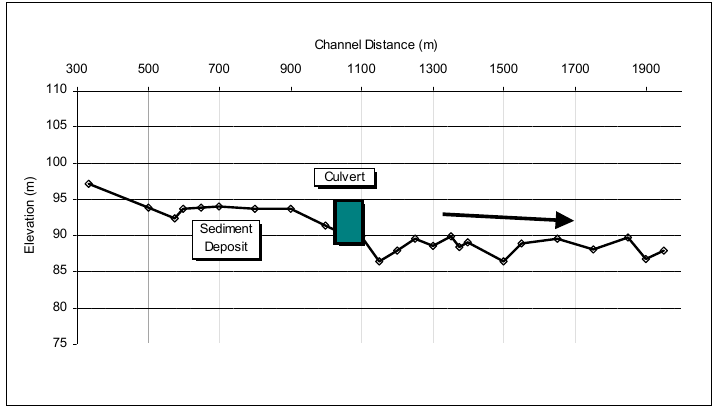
Figure 5. Culvert with upstream sediment deposit.